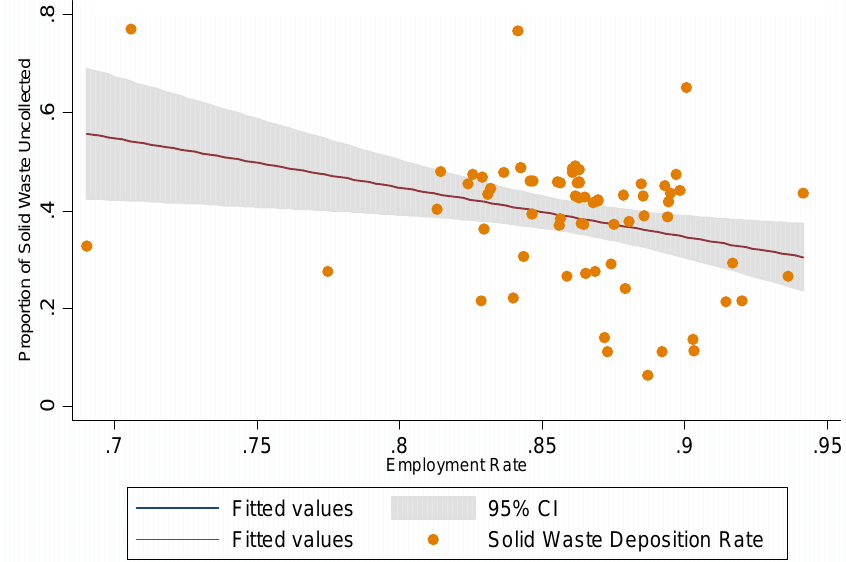
Figure 2. Variation of employment rate with proportion of solid waste deposition rate. Figure 2: Variation of employment rate with proportion of solid waste deposition rate